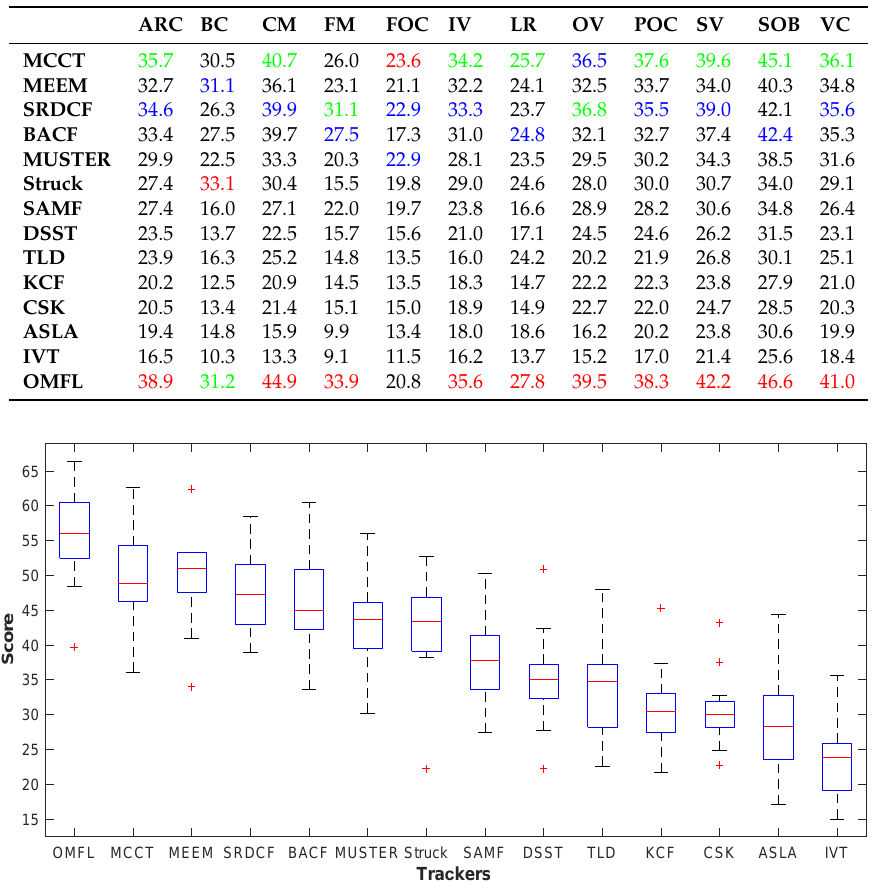
Table 3. Scores of success plots (AUC). Red, blue and green fonts indicate the best, second best and third best performances among all trackers.